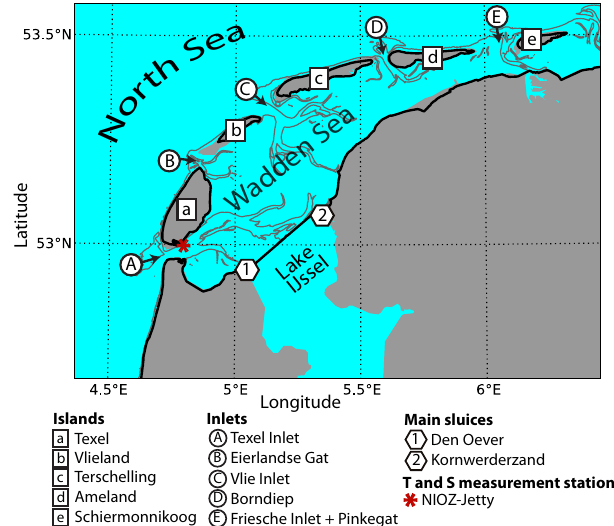
Figure 1. Map of the Dutch Wadden Sea up to the beginning of the Ems-Dollard estuary. The names of the islands and inlets are indi- cated. The position and name of the two major sluices are also indi- cated; more details on these and other sluices are given in Sect. 2.4. The grey line indicates the − 5m